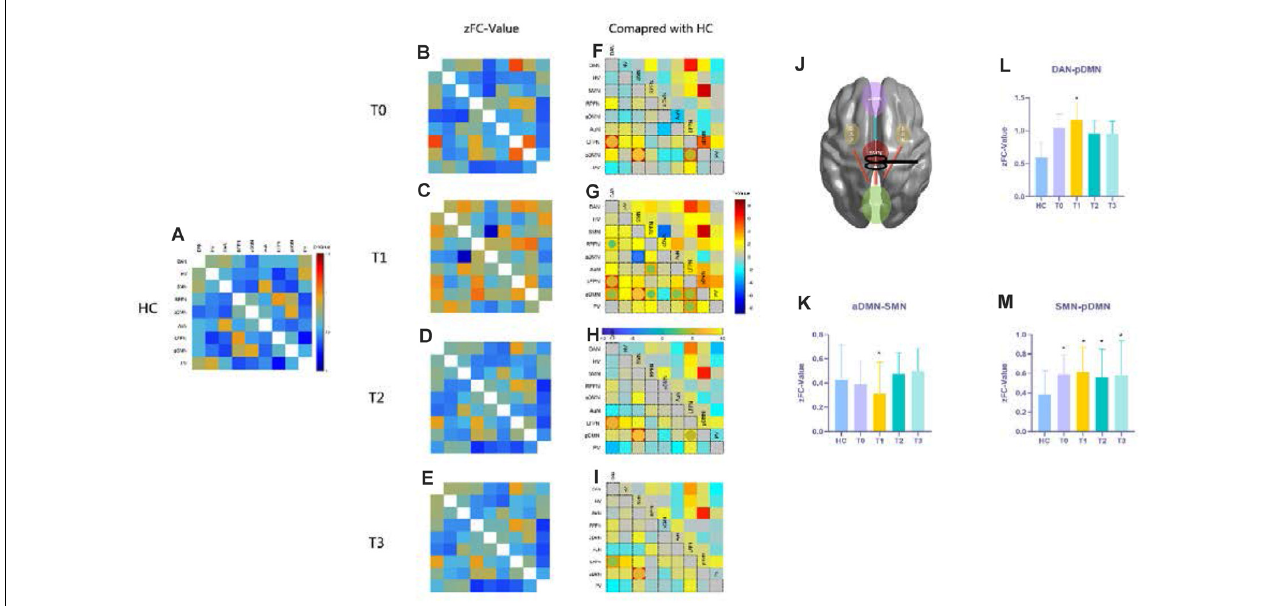
FIGURE 4 | Functional network connectivity (FNC) results compared with those of HCs. Panels (A–E) show the resting functional network results with FNC values that underwent Fisher’s r to z transformation, referring to the color bar in (A) ; (F–I) the t -maps give the information about the contrast of FC compared to HCs at each time point, the significant differences emphasized with spheres and their colors mean different t -values ( p < 0.05, FDR corrected), referring to the horizontal bar in (G) ; panels (K–M) show the FNC z -values for SMN-aDMN, SMN-pDMN, and pDMN-DAN connections in HCs and patients at each time point with the asterisks indicating a significant difference compared with HCs ( p < 0.05, FDR correlated). (J) A conceptional diagram with red lines representing hyperconnectivity and the blue line meaning hypoconnectivity after rTMS treatment. The nine functional networks are abbreviated in Supplementary Table 2 . Abbreviations: HCs, healthy controls; SMN, sensorimotor network; aDMN, anterior default-mode network; pDMN, posterior default-mode network; DAN, dorsal attention